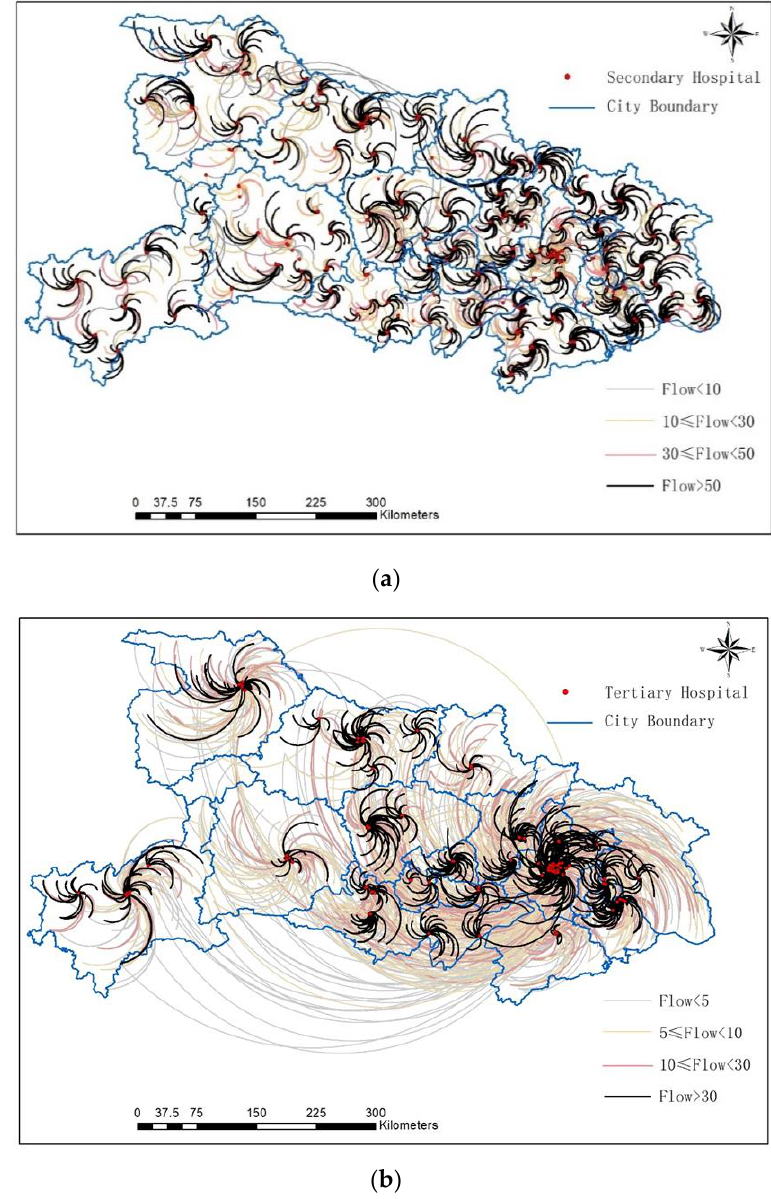
Figure 4. Maternal treatment flows. Including: ( a ) flows to secondary hospitals; ( b ) flows to tertiary hospitals.